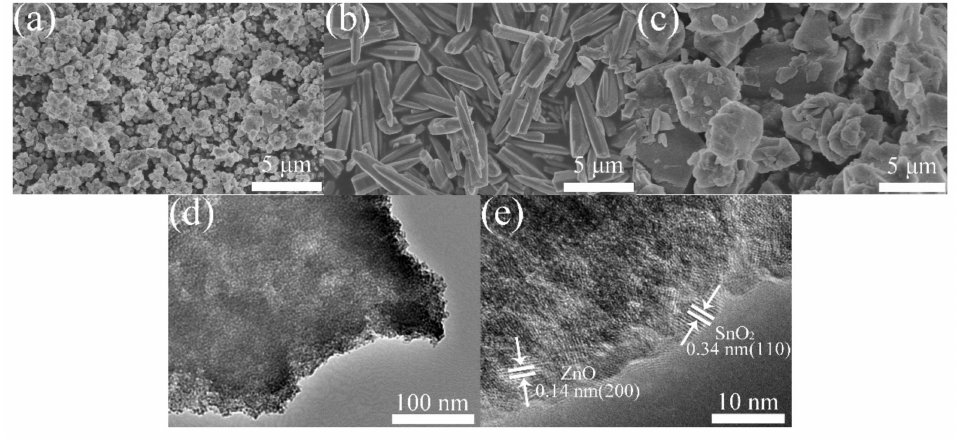
Figure 4. SEM spectra of ( a ) SnO 2 , ( b ) ZnO, and ( c ) Z/S-2 composite, and ( d , e ) TEM spectra of Z/S-2 composite.